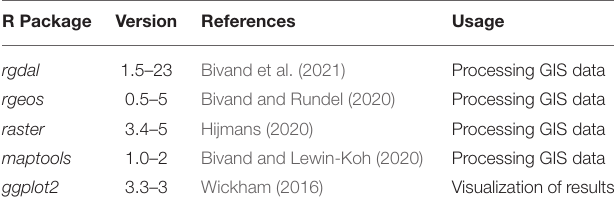
TABLE 4 | R packages used for the calibration and application of